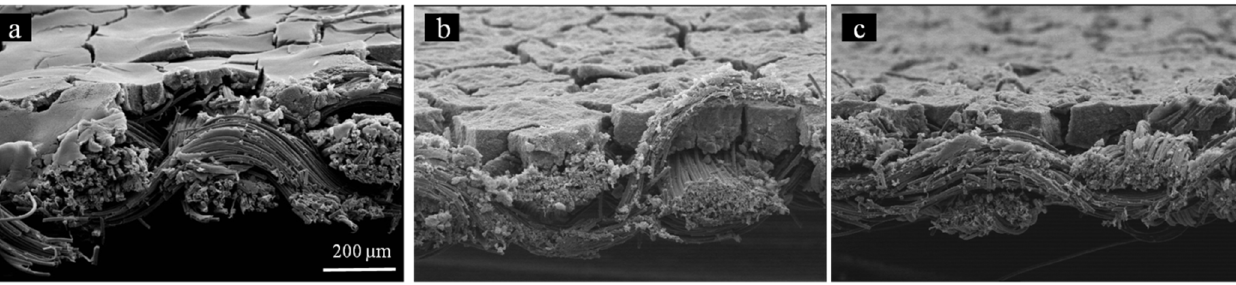
Figure 3. SEM cross-section images of GDL-MPL interfaces: ( a ) GDM-PTFE; ( b ) GDM-PFPE-12; ( c ) GDM-PFPE-6